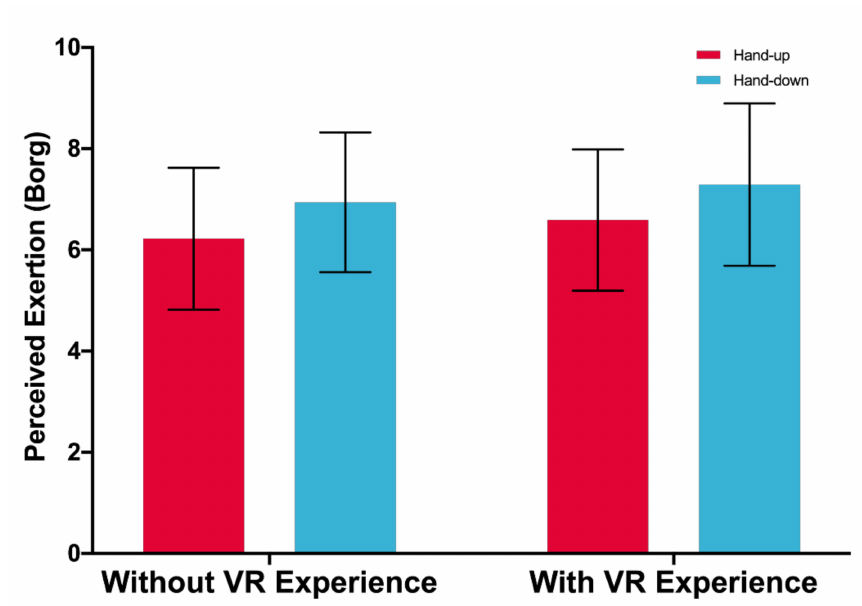
Figure 10. Perceived Exertion (10 = Highest). Error bars represent 95%